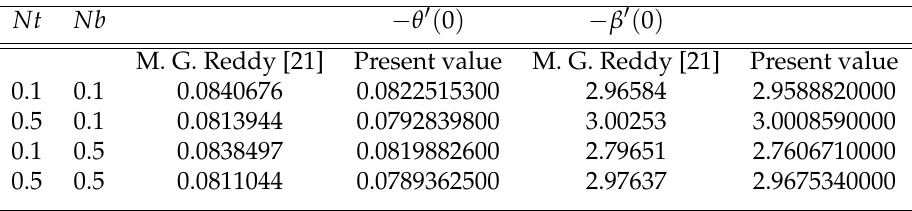
Table 2. Comparison of results of local Nusselt number − θ (cid:48) ( 0 ) and Sherwood number − β (cid:48) ( 0 )